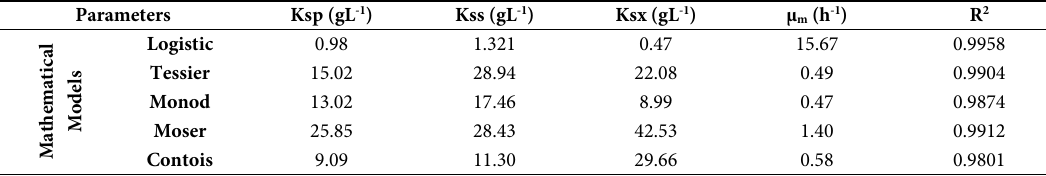
Table 2. Kinetic mathematical model parameters for